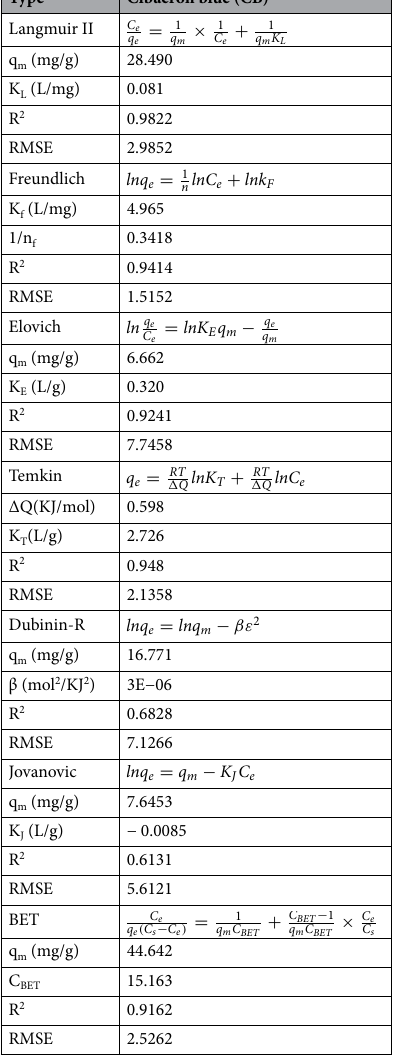
Table 5. Parameters of isothermal models studies for Cibacron blue biosorption on Bean peel (BP) biosorbent